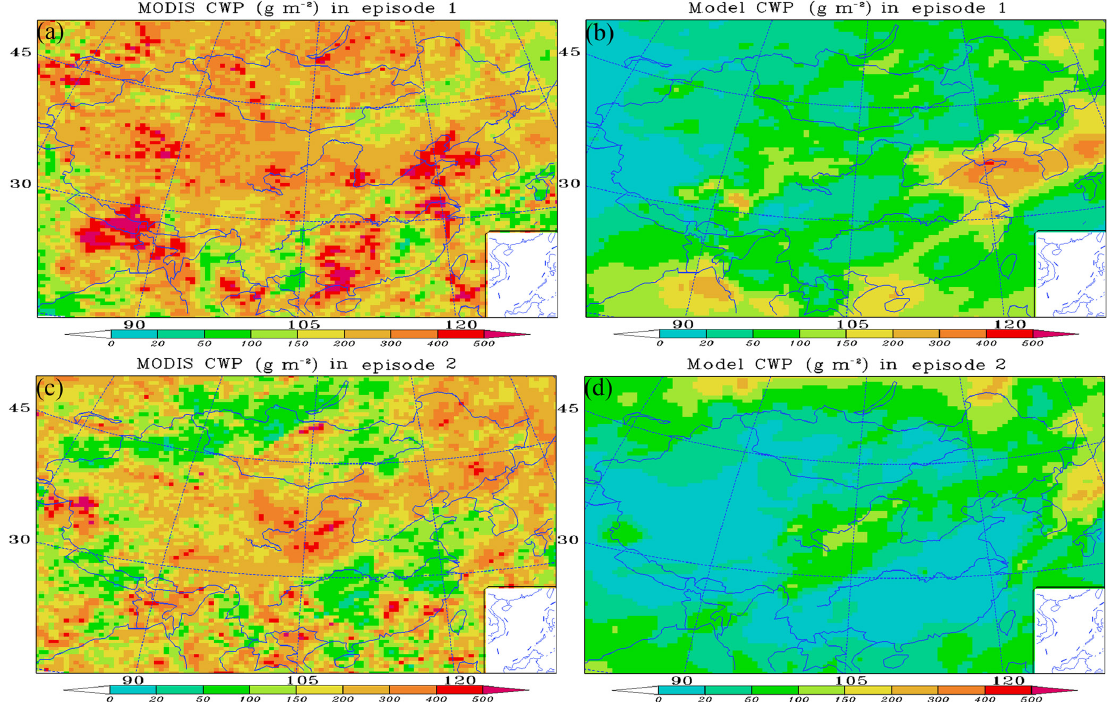
Figure 2. Observed and simulated distributions of the mean cloud water path (CWP) during the two episodes ( a , c : MODIS observation; b , d : results of simulations).